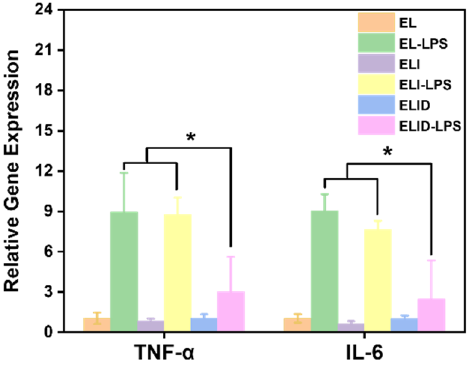
Figure 8. TNF- α and IL6 expression in U-937 cells after being treated with LPS ( n = 4, * means p ≤